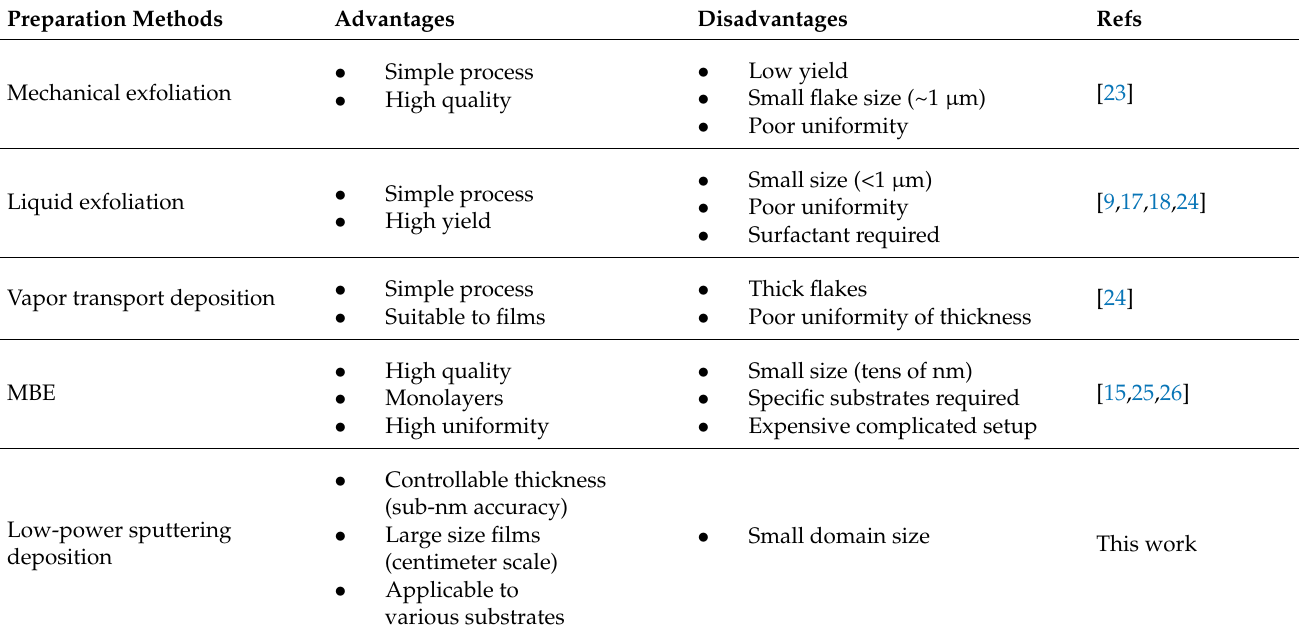
Table 1. Comparison between different preparation methods for antimonene